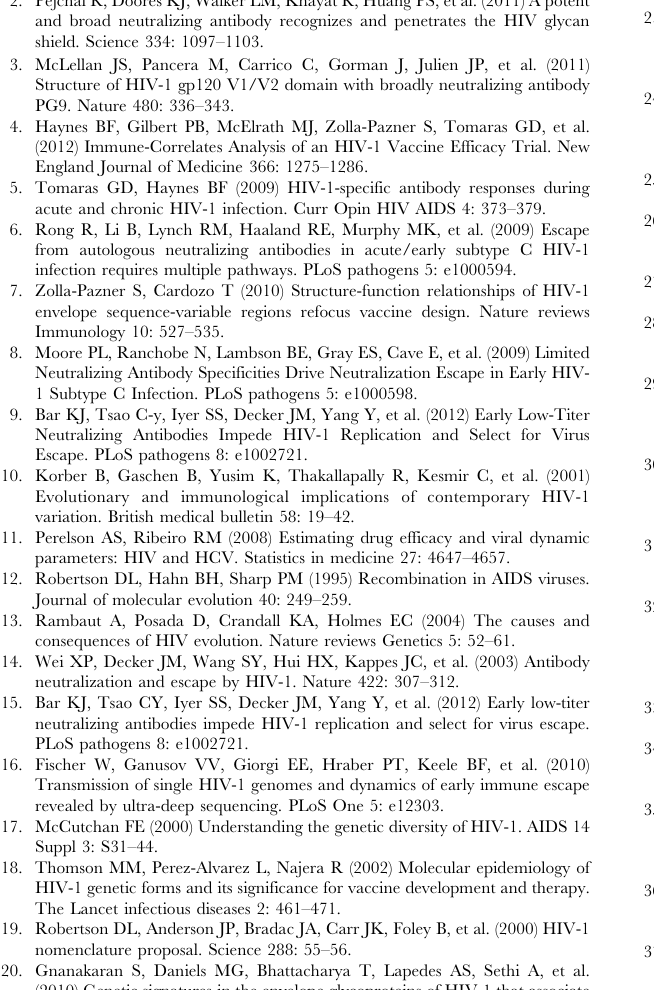
Table S6 Binding Leverage of hotspot residues identified using community analysis from HXB2 simulation. The binding leverage of a residue refers to the highest binding leverage of a site in which the hotspot residue is present. Text S1 Additional results and methods are presented in Text